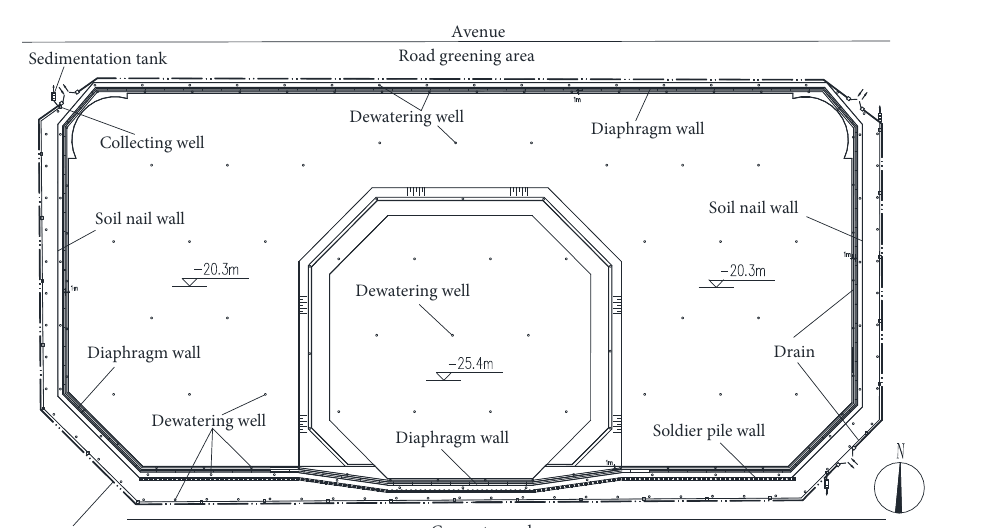
Concrete Figure 2. The layout of the excavation engineering